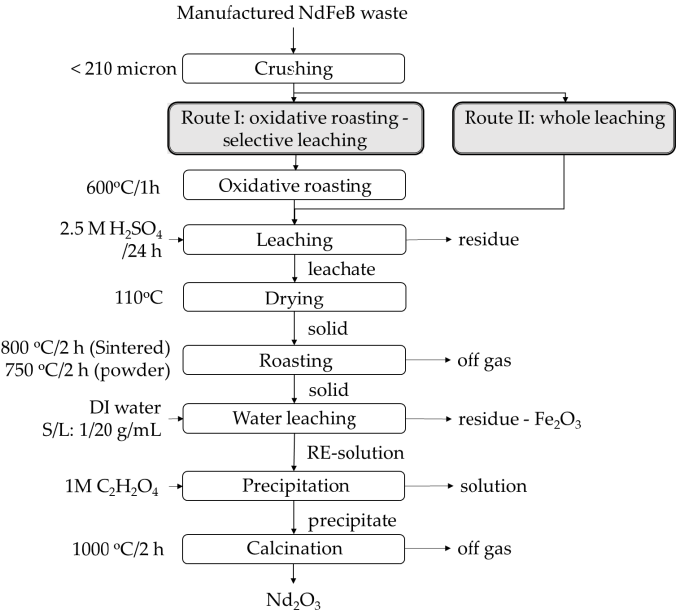
Figure 3. A schematic of manufacturing NdFeB waste recycling; route I: oxidative roasting—selective leaching, and route II: whole leaching.